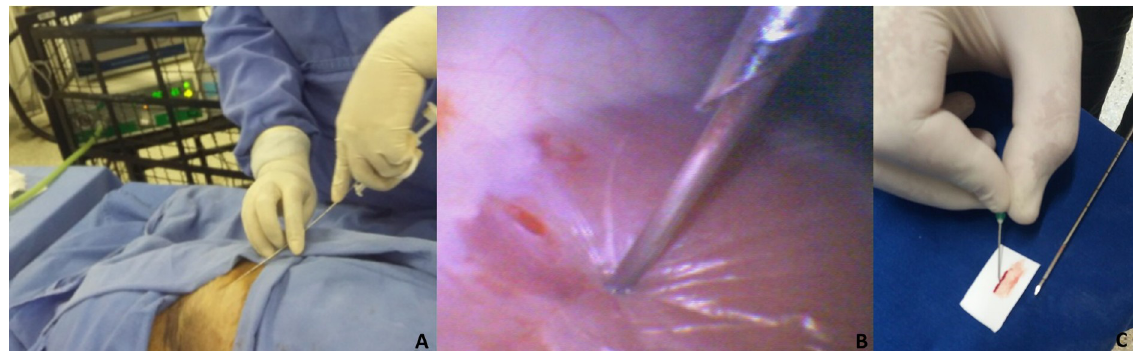
Fig 1. Percutaneous kidney biopsies guided by laparoscopy. (A) Percutaneous targeting of the Tru-cut 1 needle based on the video image. (B) Insertion of the Tru-cut 1 needle into the kidney to collect the fragment (video image). (C) Deposition of the renal fragment on designated cardboard cut for